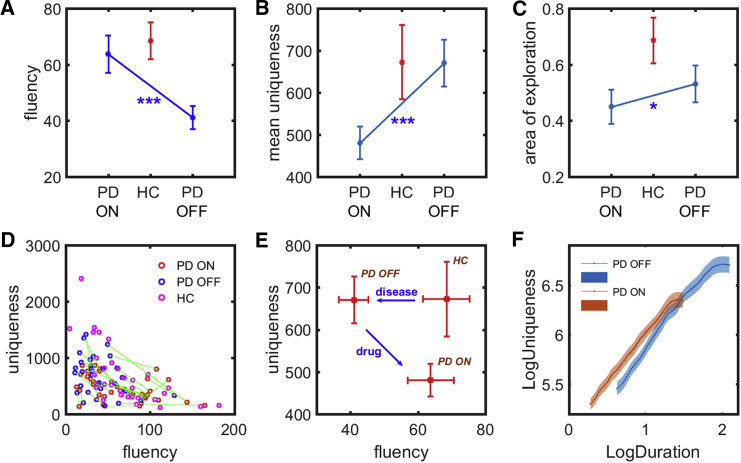
Option-Generation Task Performance in Parkinson’s Disease versus Controls(A–C) PD patients generated significantly more paths when ON compared to OFF dopamine (p < 0.001) (A). Yet, they were more unique (p < 0.001) (B) and explored a larger area in the 2-dimensional path subspace (p < 0.05) (C) when OFF their medication. Healthy age-matched controls were both fluent and creative, generating a similar number of paths to patients ON dopamine and displaying comparable uniqueness and area of exploration to patients OFF dopamine.(D) A scatterplot of each individual’s mean uniqueness of paths against their number of paths generated. The same PD patients ON and OFF dopamine are connected by green lines. There appears to be a uniqueness-fluency trade-off between generating more paths and the uniqueness of these paths.(E) A comparison of the group averages in uniqueness and fluency shows that PD reduces fluency of generation, although uniqueness is preserved. Administration of dopamine restores the number of paths generated but at the expense of reduced uniqueness. This suggests that dopamine may play an important role in modulating the balance between generating more options against producing more unique outputs.(F) Because fluency correlates with uniqueness, a linear mixed effects model was used to examine how each path’s duration (or inverse of fluency) influences uniqueness. Dopamine was found to increase the uniqueness of paths after correcting for the fact that they were faster (red line significantly higher than blue line; p = 0.005).Error bars refer to one SE. HC, healthy controls; PD, Parkinson’s disease. See also Figures S2, S3, S4, S5, and S7 and Table S3.